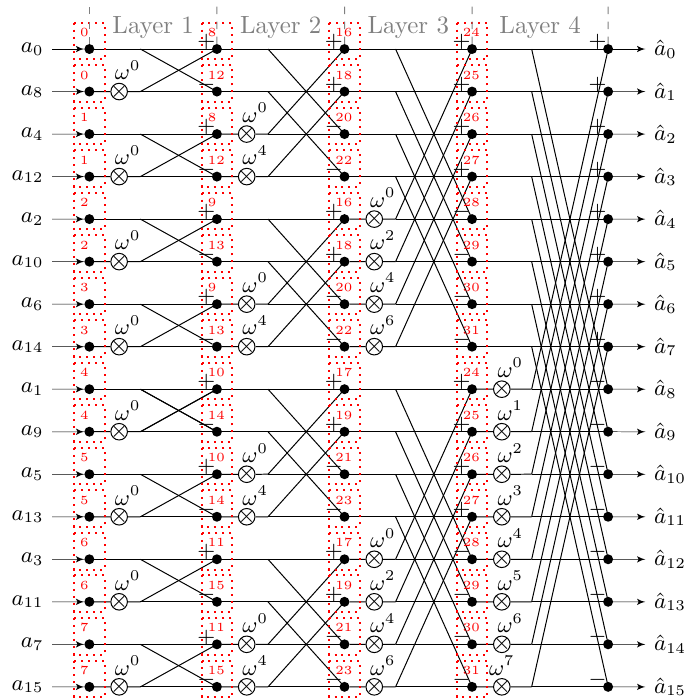
Figure 9: Example NTT CT with n = 16 (unoptimized). In this case, one coefficient is br ← no stored in a single memory word, two coefficients can be loaded to the register file ( l = 2), and one pair of coefficients can be executed in parallel. The red boxes indicate which coefficients are stored together in one word (in this case they are not stored together) and in which order the coefficients are processed by a single butterfly